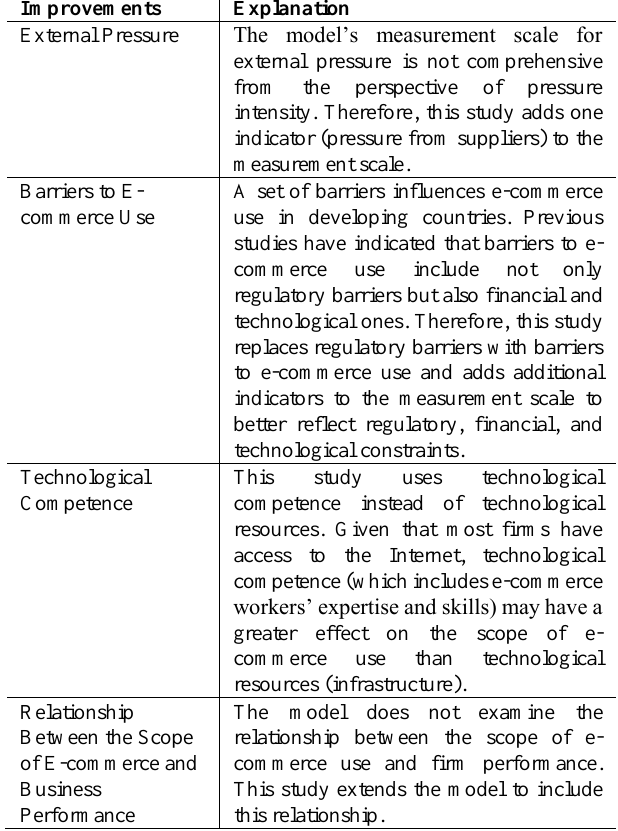
Table 1: Proposed improvements to Gibbs and